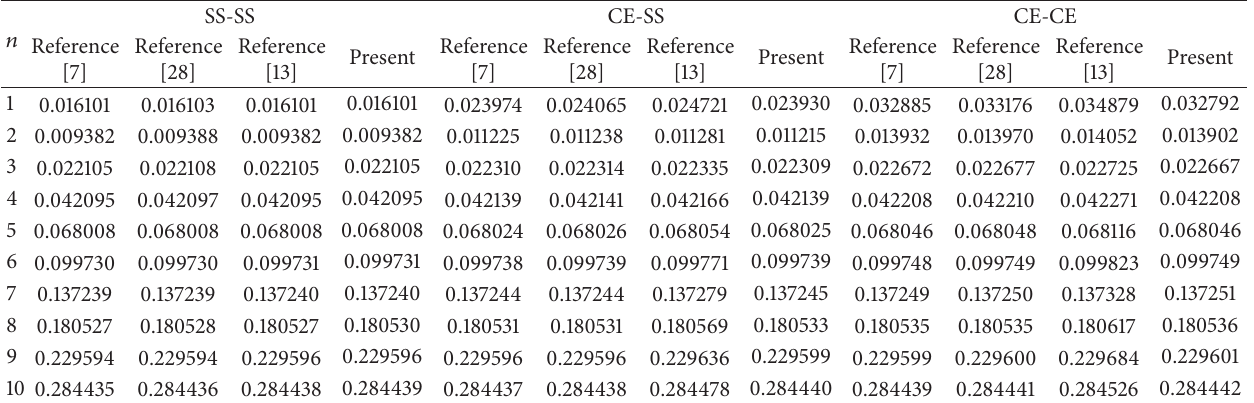
Table 2: Comparison of the frequency parameter Ω = 𝜔𝑅[(1 − 𝜇 2 )𝜌/𝐸] conditions ( 𝑅 = 1m, 𝐿/𝑅 = 20 , ℎ/𝑅 = 0.01 , 𝑚 =